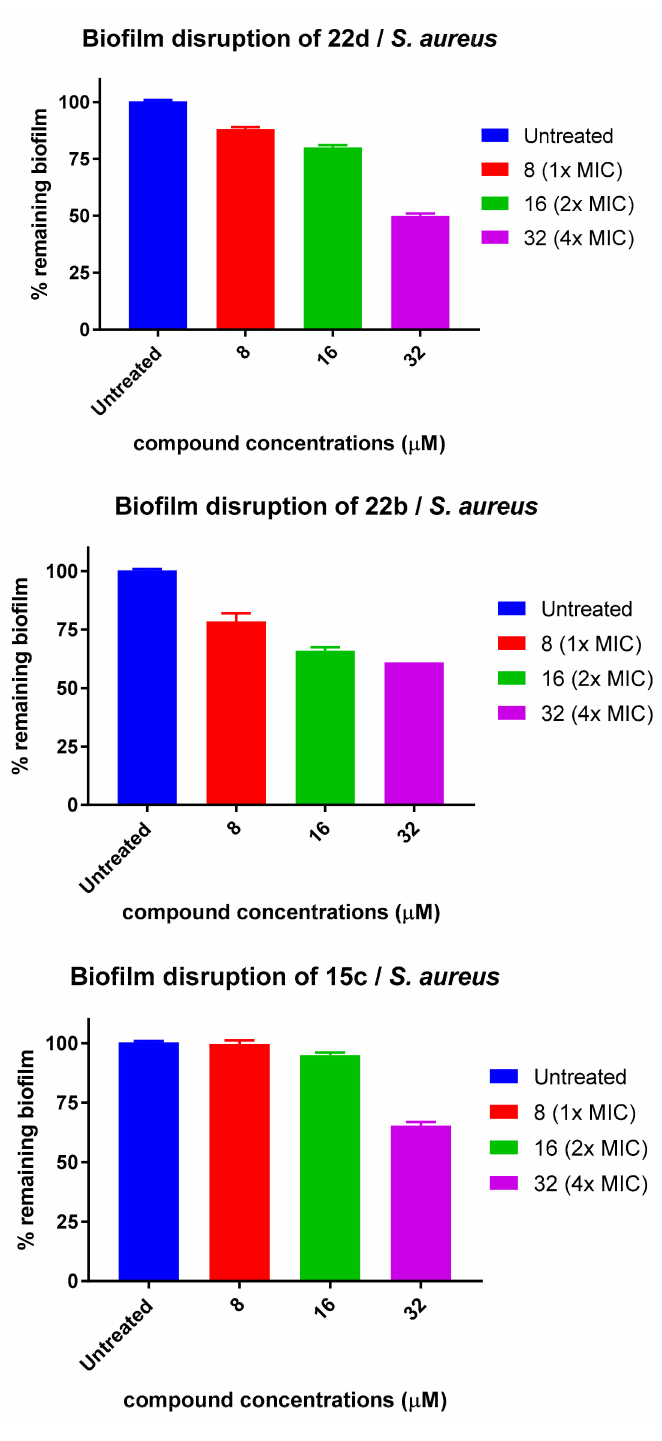
Figure 4. Percentage of remaining S. aureus biofilms after 24 h treatment with compounds 22d (top), 22b (middle) or 15c (bottom) at 1 × , 2 × and 4 × of their MIC. Error bars represent the standard error of triplicates ( n =